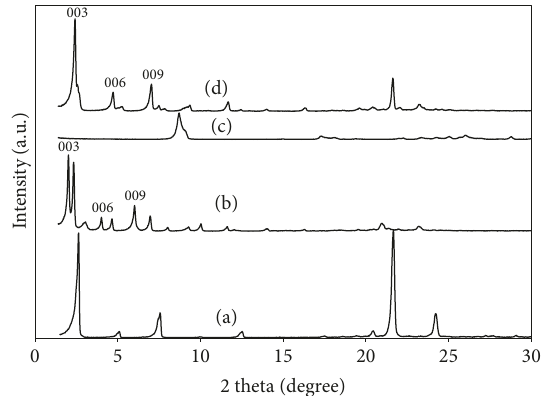
Figure 2: X-ray diffraction patterns: (a) palmitic acid, (b) Zn/Al palmitate, (c) zinc hydroxide nitrate (ZHN), and (d) zinc hydroxide nitrate intercalated by the anion palmitate (LHS